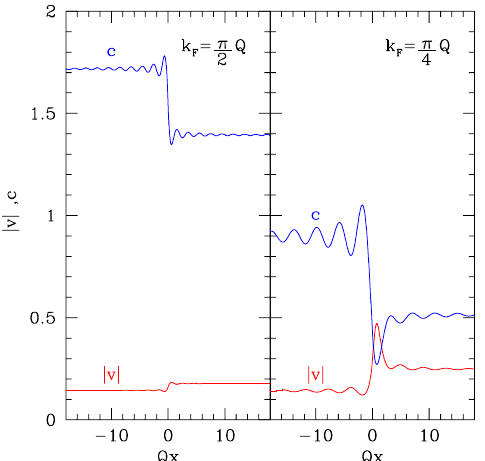
Figure 2. Absolute value of the fluid velocity (red) and of the sound speed (blue) in the stationary states corresponding to k 0 = 0 and two different Fermi momenta: k F = π (right panel). Velocities are in unit of ¯ hQ